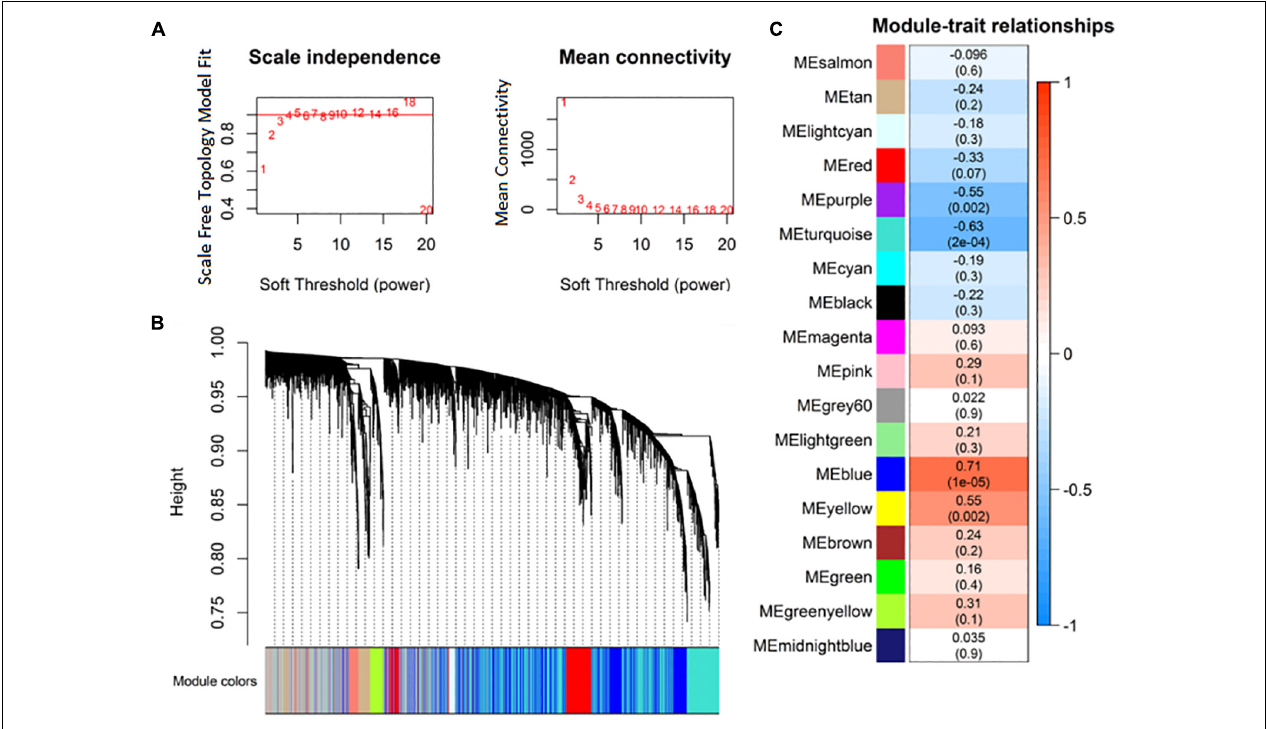
FIGURE 3 | Identification of co-expression modules of RNA transcripts. (A) Analysis of RNA network topology for various soft-thresholding powers; (B) RNA expression module clustering dendrograms based on topological overlap; (C) association of RNA expression modules with major depressive disorder